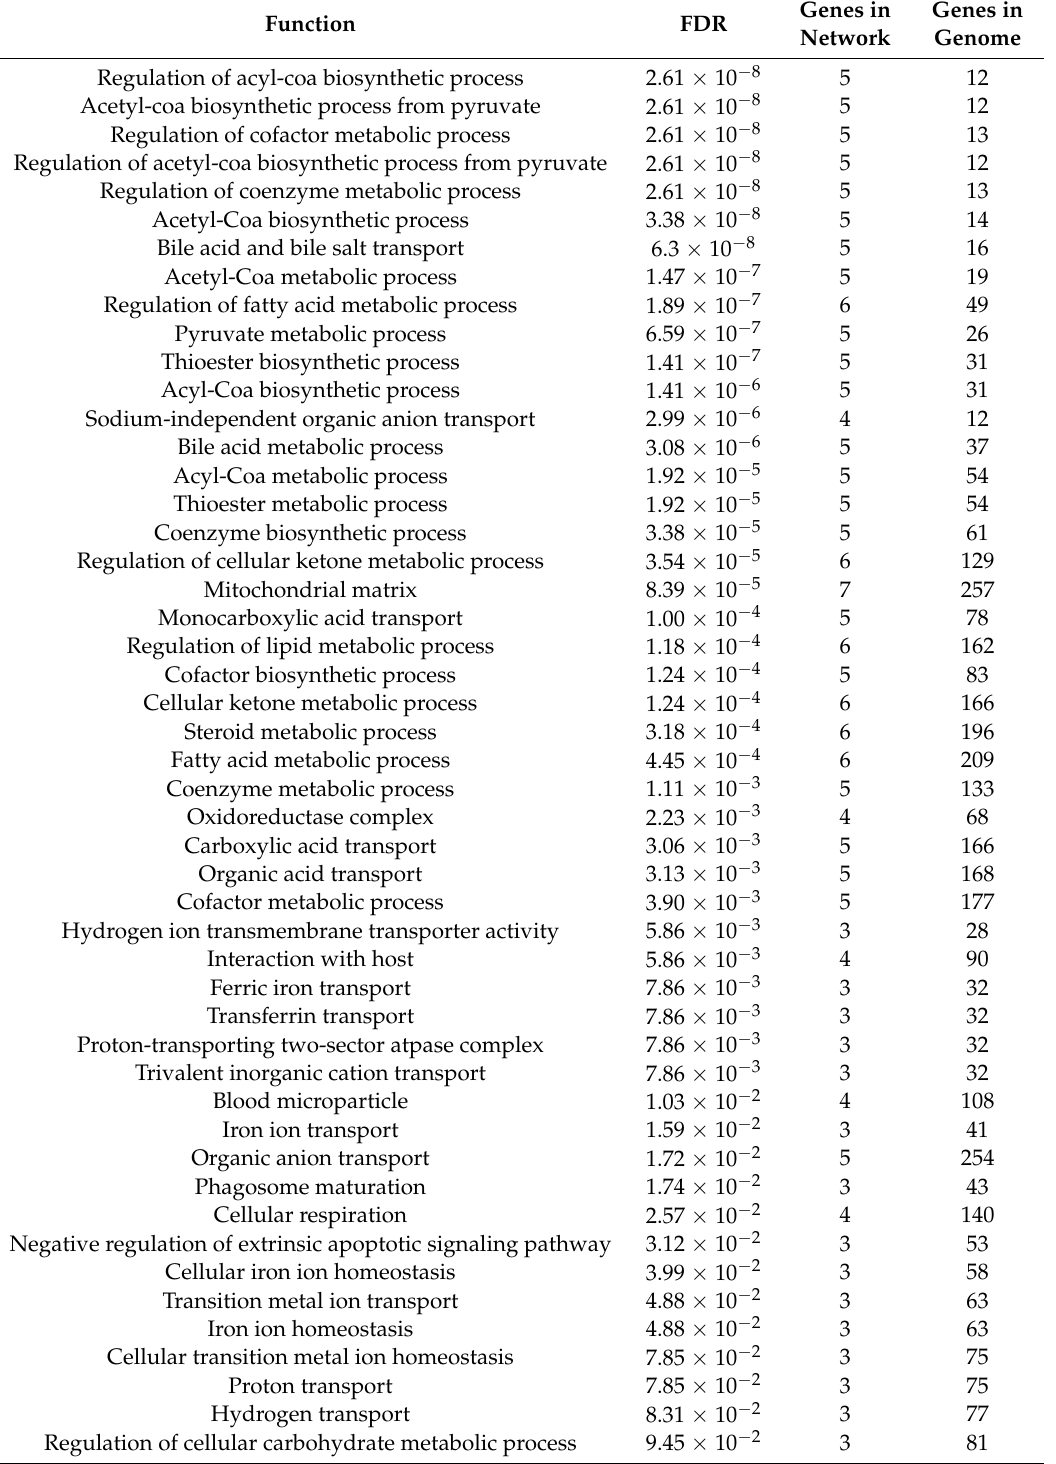
Genes in Genes in Network Genome